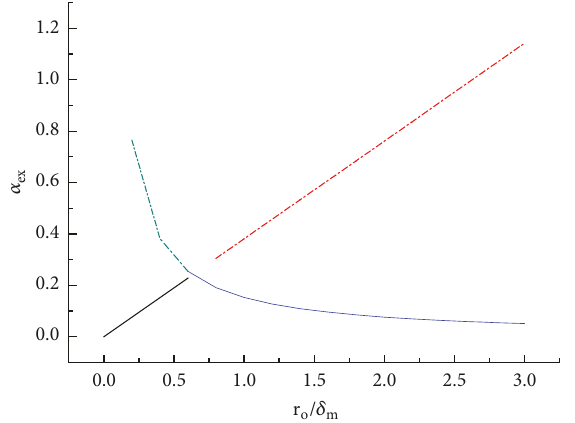
Figure 4: Dependence of 𝛼 ex on ratio of r o to 𝛿 m .